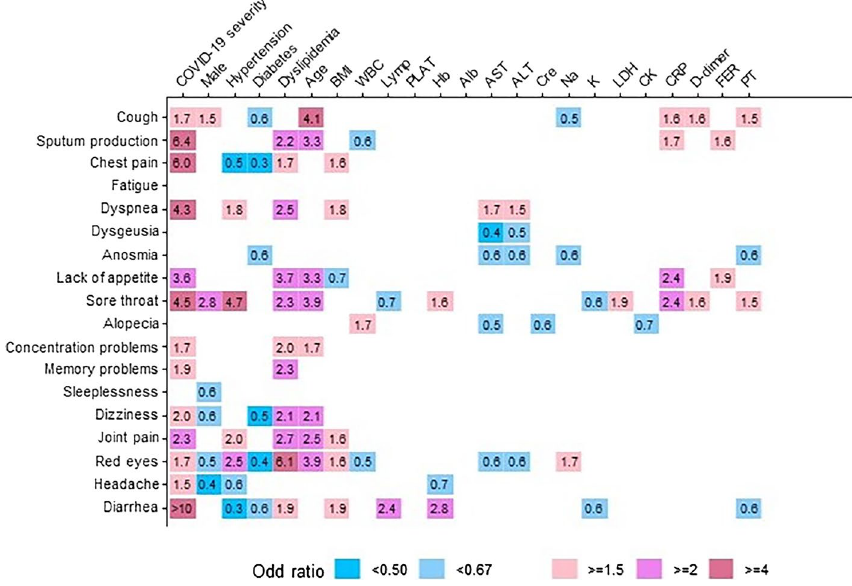
Figure 3. Risk factors for each persistent symptom using univariable ordinal logistic regression.